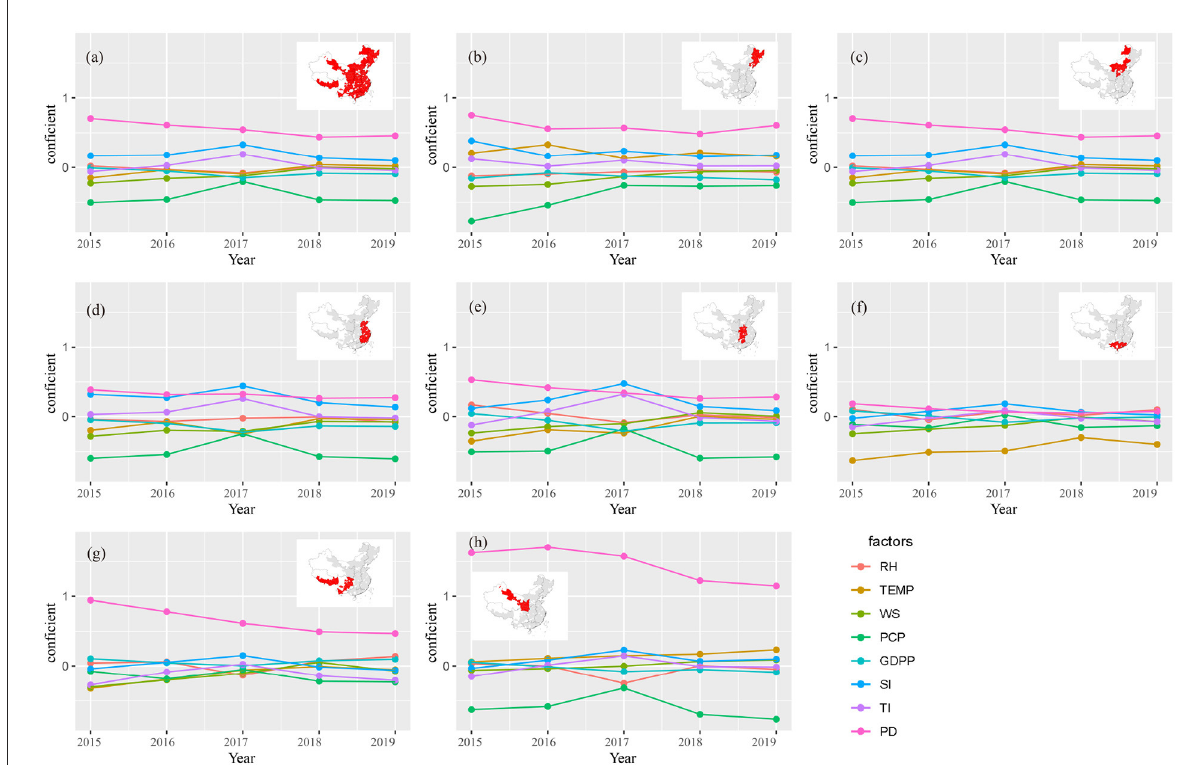
FIGURE6 Trends in driving capability of each factor in different spaces from 2015 to 2019 (a) Whole region, (b) Northeast China, (c) North China, (d) East China, (e) Central China, (f) South China, (g) Southwest China, and (h) Northwest China.